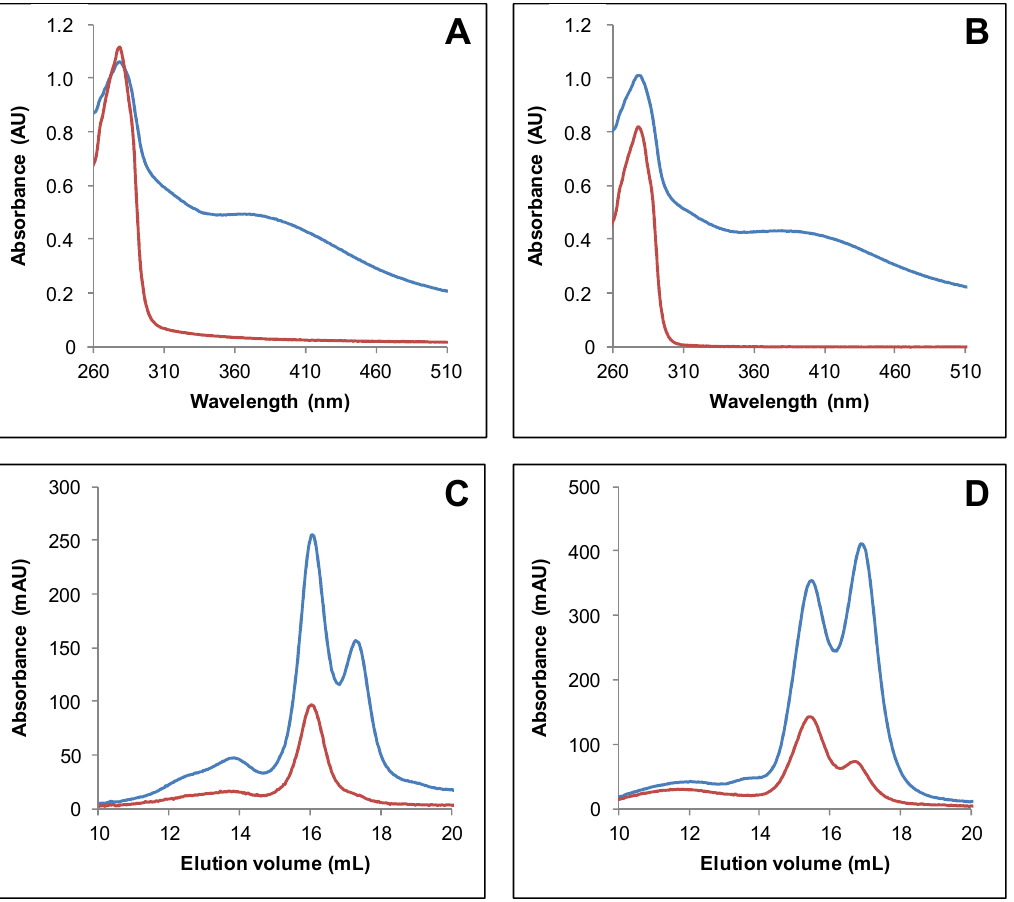
Figure 2. IscS-mediated in vitro Fe-S cluster reconstitution of Arabidopsis TRXo isoforms. UV–visible absorption spectra of TRXo2 ( A ) and TRXo1 ( C ) before (red line) and after (blue line) an anaerobic reconstitution performed in the presence of IscS in Tris NaCl buffer. Analytical gel filtration of reconstituted TRXo2 ( B ) and TRXo1 ( D ) was performed by loading 100 to 300 µg of protein (including 10 µM of EcIscS) onto a Superdex S200 10/300 column. The presence of the polypeptide and of the Fe-S cluster have been detected by the absorbance at 280 nm (blue line) and 420 nm (red line), respectively.